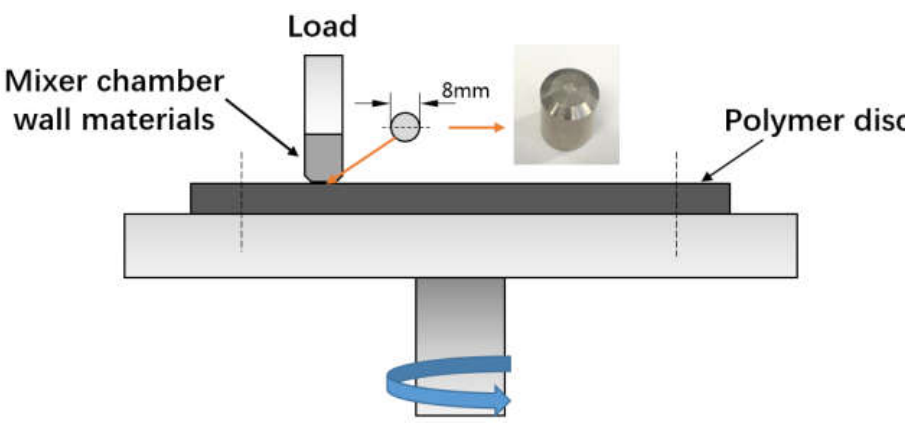
Figure 2. The friction test mode. Before each test, the surface metal was wiped with alcohol, and the test points were marked on the metal surface to record the coordinates of the test points, which was convenient for the observation of the surface morphology after the friction test. The friction coefficient was continuously recorded by an online data acquisition system attached to the Tribometer of Anton Paar (short for CSM). The friction coefficient was the average value during each part of the friction test. The surface morphologies of the metal and rubber samples before and after friction were observed using the three-dimensional topography instrument (Olympus 4500) to track the sliding trajectory and magnified the test point at the same position with a 20 × objective lens. The measured area was about 640 µ m × 640 µ m, and the surface change of the wear rate, Sa , Sp , and Sv of the metal were calculated, and the calculations are shown in Equations (1)–(4)